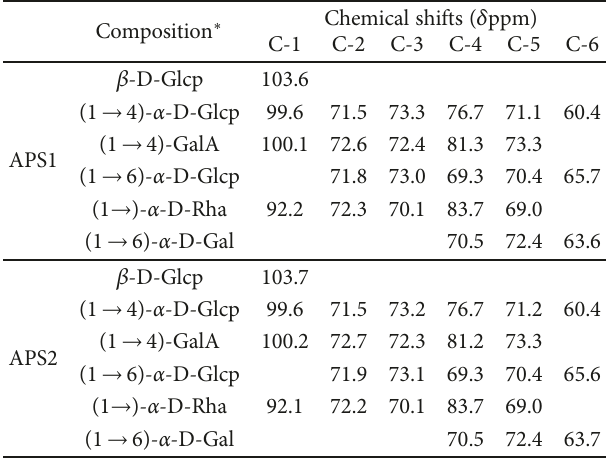
Table 3: Structure characterization of APS1 and APS2 by 13 C NMR